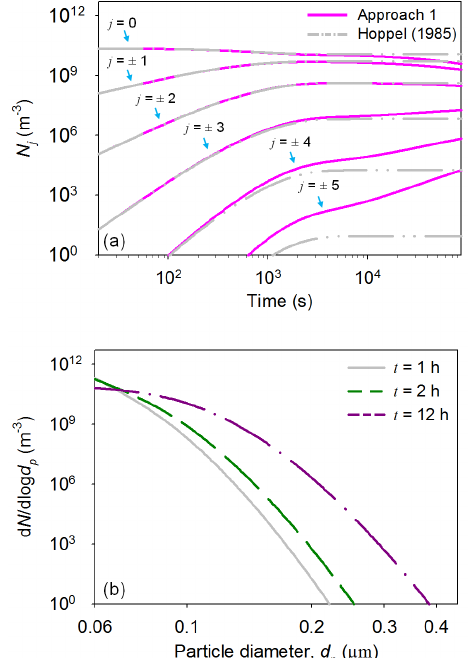
Figure 10. Time evolution of the charge (a) and size (b) distributions of atmospheric particles in the postulated atmo- sphere of Hoppel (1985) ( d p = 0 . 06µm, N t = 2 . 3 × 10 10 m − 3 ; q = 10 7 m − 3 s − 1 ) . Approach 1 was used to involve the effects of coag- ulation on the Hoppel (1985) simulation.